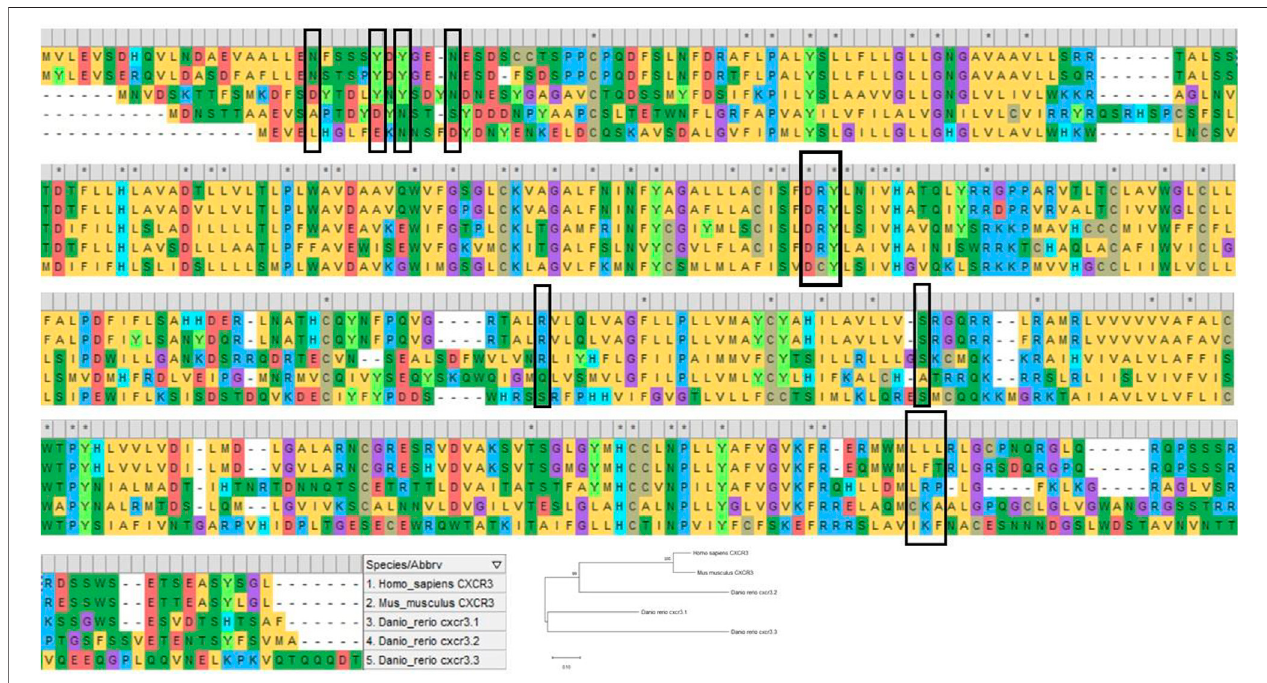
FIGURE 4 | The image shows multiple sequence alignment of human CXCR3A, murine CXCR3 and zebra fi sh Cxcr3.1, Cxcr3.2, and Cxcr3.3. The highlighted residues(blackbox)showtheconservationofessentialdomainsinhumans,mice,andzebra fi sh.ThesequencealignmentwasdoneusingMEGAX(Kumaretal.,2018).